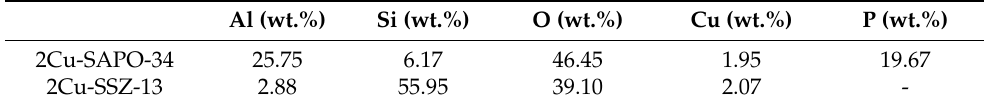
Figure 3. HR-TEM images and EDX mapping of the Cu-containing zeolites ( a ) 2Cu-SAPO-34 and ( b ) 2Cu-SSZ-13. Table 2. Composition obtained with EDX mapping of